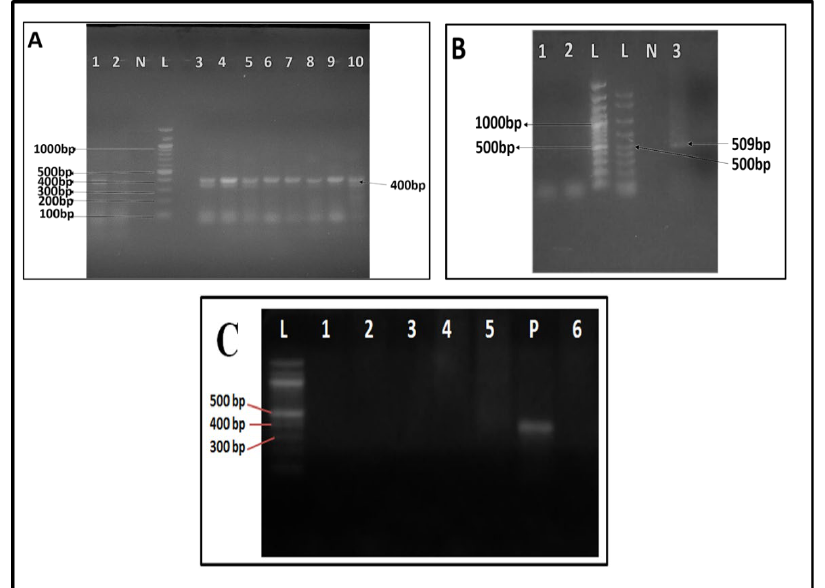
Figure 2. Agarose gels showing PCR results of samples from cattle ( A ), dogs ( B ) and humans ( C ) L: 100 base pair ladder. ( A ): Lanes 1, 3 - 10: PCR products showing band sizes of about 400 base pairs from amplification with Babesia/Theilaria primers, N—negative control, ( B ): Lanes 1–3 suspected dog samples, Lane 3—PCR amplification with B. canis primers; arrow shows a band size around 509 bp C: Lanes 1–6: suspected human samples after PCR showing no bands with the Babesia/Theilaria primers, P: positive control.